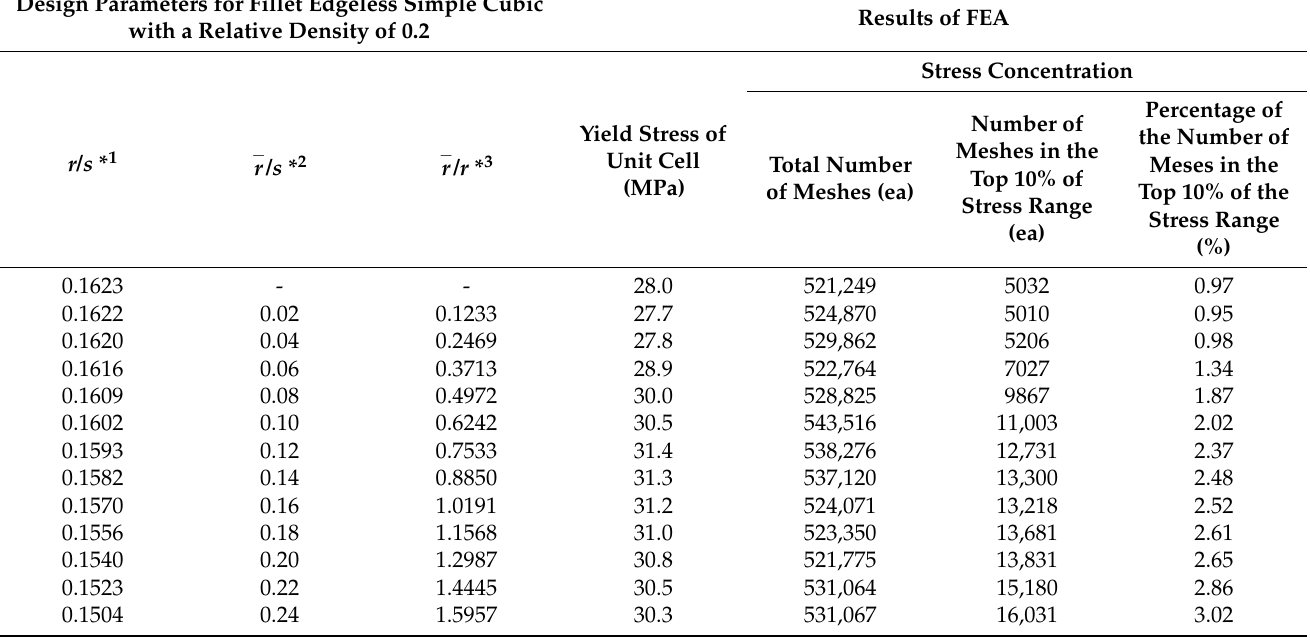
Table 2. FEA results for the fillet edgeless simple cubic unit cells. Design Parameters for Fillet Edgeless Simple Cubic with a Relative Density of